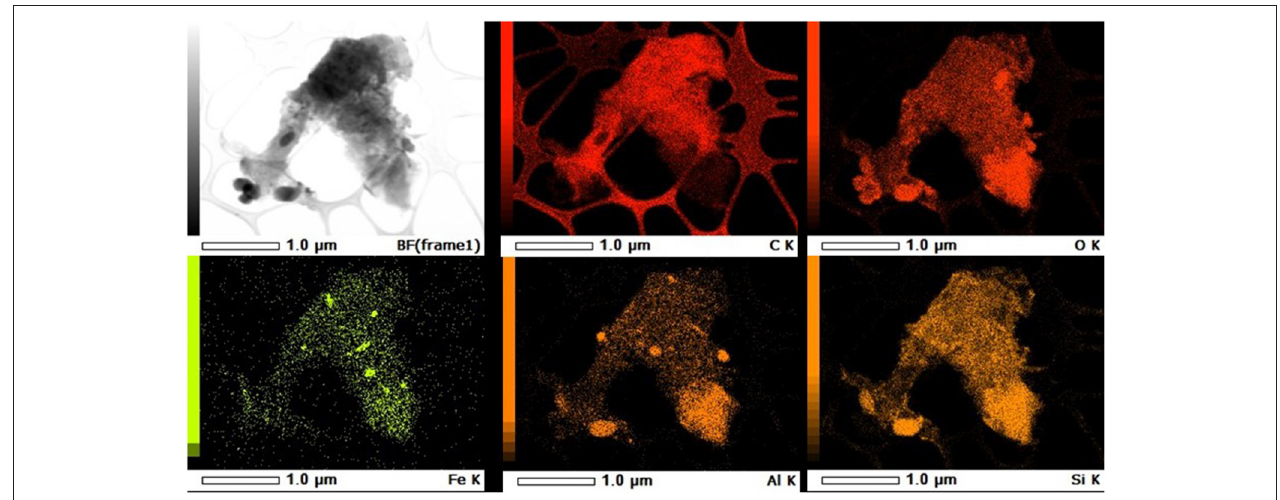
FIGURE 2 | Representative TEM-EDS map of water extracted colloids from Tims Branch Sediment Anaerobic sample. First image is TEM. The remaining images are EDS elemental maps of the same image showing relative intensity of each element. Scale and element are listed in footer for each